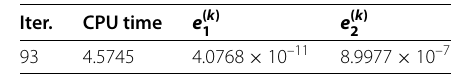
Table 2 Iteration number, CPU time, and values of e ( k )